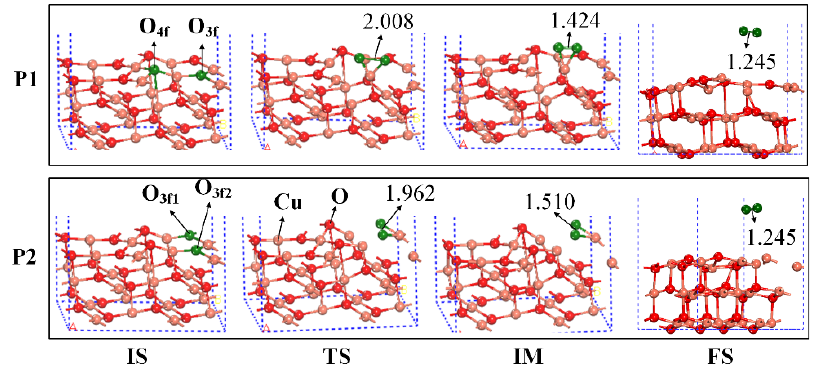
the oxygen release process on the CuO surface exist in pairs.